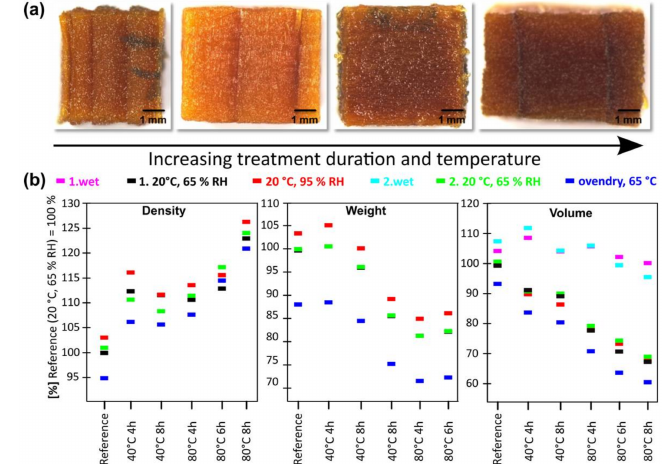
Figure 3. Characterization of soda pulped spruce wood cubes. ( a ) Light microscopy images of the soda pulped cubes of spruce wood. ( b ) Relative density variation, weight loss and volume changes for soda pulped samples treated under different conditions and monitored under the influence of changing climate conditions (colour